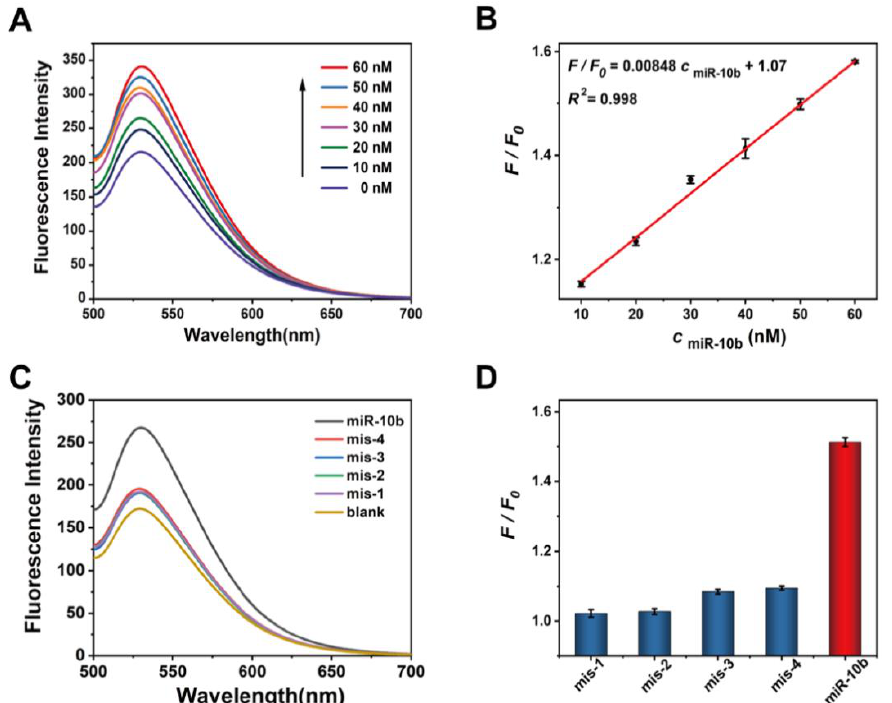
Figure 4. ( A ) Fluorescence emission spectra of the DNAzyme amplifier in the presence of different concentrations of miR-10b, from bottom to top: 0 nM, 10 nM, 20 nM, 30 nM, 40 nM, 50 nM, and 60 nM. ( B ) The linear relationship between F / F 0 and the concentration of miR-10b. ( C ) Fluorescence emission spectra of the DNAzyme amplifier in the presence of miR-10b and homologous miRNAs sequences with different mismatch bases. ( D ) Selectivity for the detection of miR-10b. Error bars represented the standard deviation of three determinations. Experimental conditions: substrate concentration of 25 nM, DNAzyme concentration of 25 nM, blocker concentration of 30 nM, Mn 2+ concentration of 750 μM , 25 mM Tris-HCl buffer (containing 137 mM NaCl, pH 7.0).